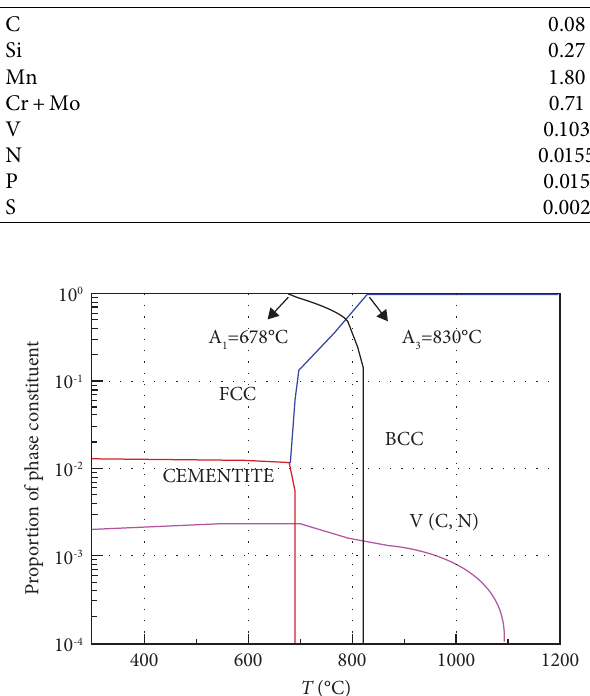
Figure 1: Phase diagram calculation for experimental steel based on thermo-calc.